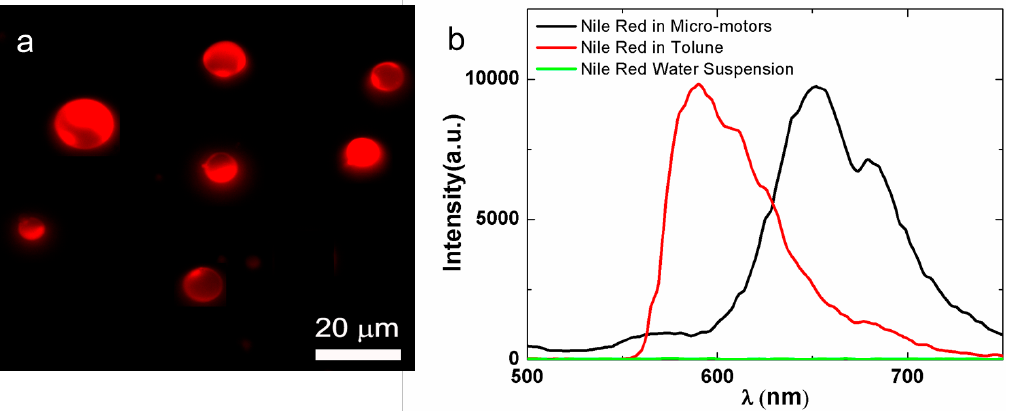
Figure 3. ( a ) Fluorescent microscopy image and ( b ) fluorescent emission spectrum of the magnetic/fluorescent hybrid micro-motors in aqueous solution.